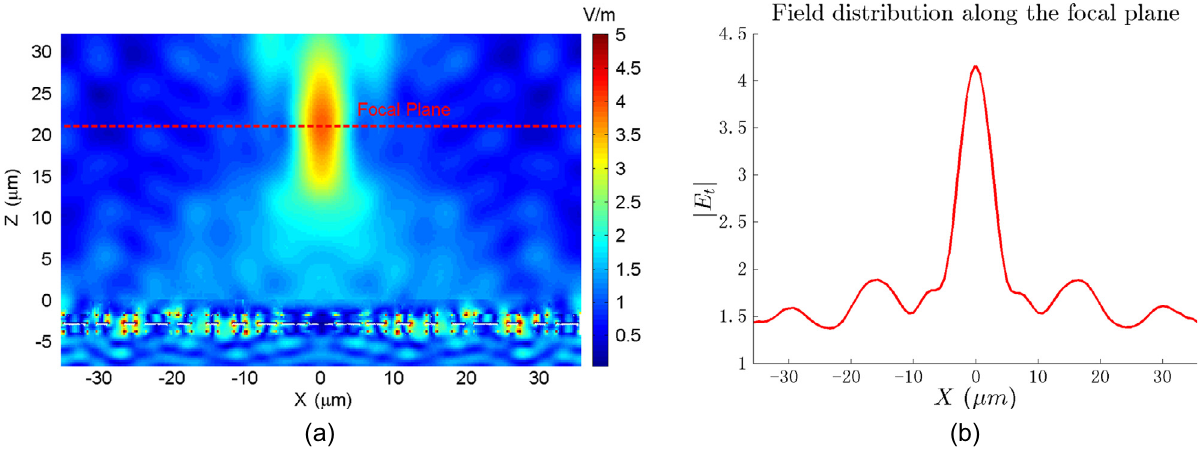
Figure 8. Complex magnitude of the transmitted field. (a) The simulated focal length is taken to be the center of the beam spot which is 20.6 l m away from the transmitarray and the designed focal length is 21 l m, (b) the complex magnitude of the transmitted E-field across the p V/m and the peak magnitude of the focused field is 3.89 V/m. The transmitarray has a focal plane. The incident field magnitude is ffiffiffi 2 focusing power of 2.75 times.